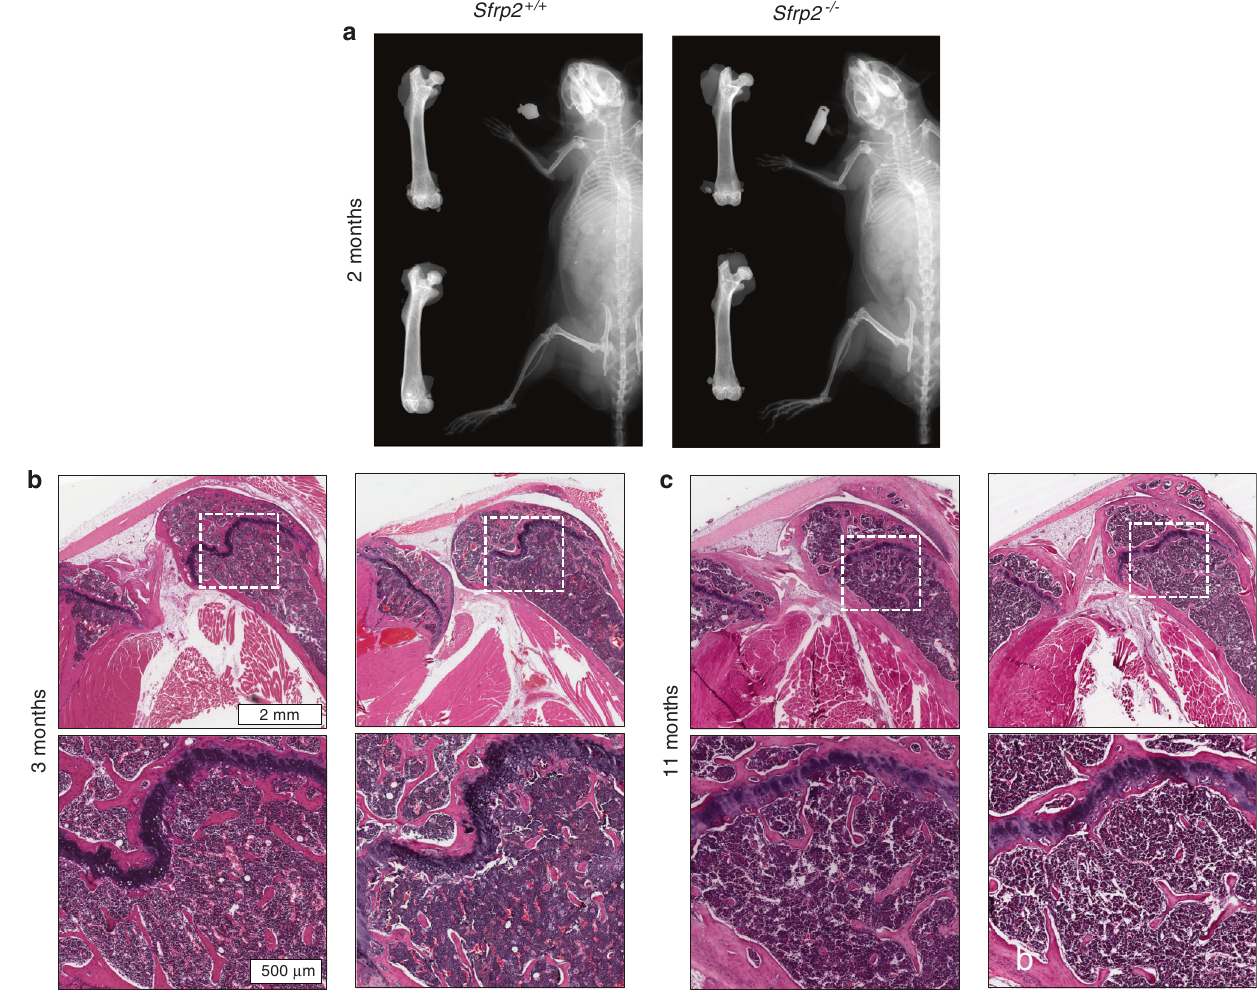
Fig. 2 Sfrp2 KO mice do not exhibit radiological or histological skeletal differences compared with WT mice. a Representative X-ray images of 2-month-old male mice femora and full skeletons. b , c Micrographs (top row) of mid-sagittal H&E-stained sections of the knee joint, with femora on the right and tibiae on the left, and high magni fi cation micrographs of the sub-metaphyseal area of femora (bottom row), of male mice at 3 months ( b ), and 11 months ( c